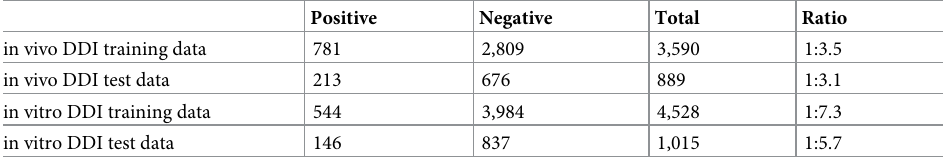
Table 7. The statistics from the PK DDI corpus after preprocessing. Positive